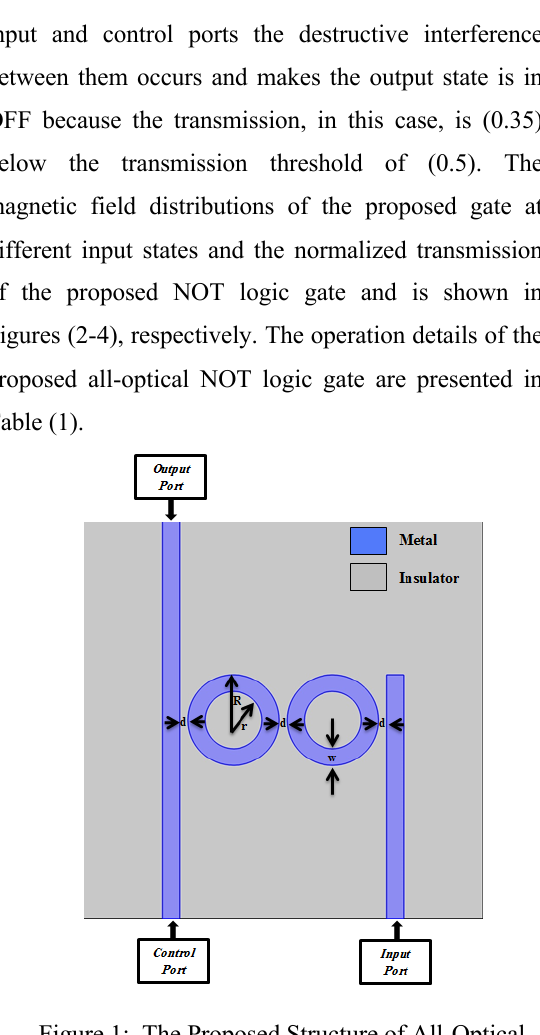
Figure 1: The Proposed Structure of All-Optical Plasmonic NOT Gate.